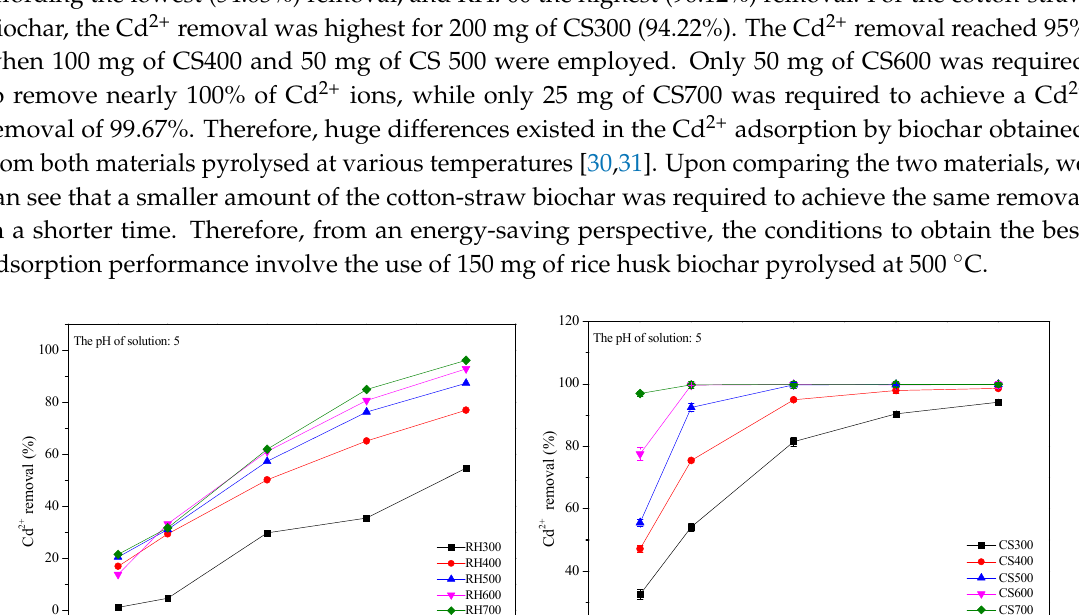
Figure 2. Fourier-transform infrared (FTIR) spectra of the biochar samples obtained at various pyrolysis temperatures. Notes: RH300, RH400, RE500, RH600, and RH700 indicate that rice husk were pyrolyzed at 300, 400, 500, 600 and 700 °C, respectively; CS300, CS400, CS500, CS600, and CS700 indicate that cotton straw were pyrolyzed at 300, 400, 500, 600 and 700 °C, respectively.